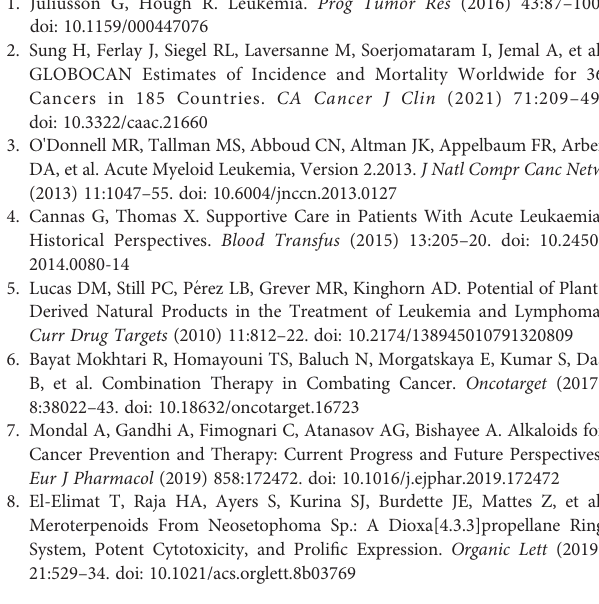
Supplementary Figure 1 | Spearman correlation between BUB1B and FOXM1 in TCGA cancers plotted using log2 TPM expression values. Correlation score (r) and p values (p) are plotted on top left. LAML, Acute Myeloid Leukemia; ACC, Adrenocortical carcinoma; BLCA, Bladder Urothelial Carcinoma; LGG, Brain Lower Grade Glioma; BRCA, Breast invasive carcinoma; CESC, Cervical squamous cell carcinoma and endocervicaladenocarcinoma; CHOL, Cholangiocarcinoma; LCML, Chronic Myelogenous Leukemia; COAD, Colon adenocarcinoma; ESCA, Esophageal carcinoma; GBM, Glioblastoma multiforme; HNSC, Head and Neck squamous cell carcinoma; KICH, Kidney Chromophobe; KIRC, Kidney renal clear cell carcinoma; KIRP, Kidney renal papillary cell carcinoma; LIHC, Liver hepatocellular carcinoma; LUAD, Lung adenocarcinoma; LUSC, Lung squamous cell carcinoma; DLBC, Lymphoid Neoplasm Diffuse Large B-cell Lymphoma; MESO, Mesothelioma; MISC, Miscellaneous; OV, Ovarian serous cystadenocarcinoma; PAAD, Pancreatic adenocarcinoma; PCPG, Pheochromocytoma and Paraganglioma; PRAD, Prostate adenocarcinoma; READ, Rectum adenocarcinoma; SARC, Sarcoma; SKCM, Skin Cutaneous Melanoma; STAD, Stomach adenocarcinoma; TGCT, Testicular Germ Cell Tumors; THYM, Thymoma; THCA, Thyroid carcinoma; UCS, Uterine Carcinosarcoma; UCEC, Uterine Corpus Endometrial Carcinoma; UVM, Uveal Melanoma. Supplementary Figure 2 | Overall survival BUB1B for the solid tumors from TCGA. Higher expression of BUB1B is associated with poor overall survival in six different cancers. Supplementary Figure 3 | NSP-B synergistically enhanced the antiproliferative responseofthiostreptoninleukemiccells.K562 (A) andU937 (B) cellsweretreated withvarious combinations ofNSP-B and thiostrepton for 48 hours and graphs were generated.K562 and U937 cells were treated with different combinations of NSP-B and thiostrepton for 48 hours and cell viability assay were performed as mentioned in the method section. Different types of graphs were prepared using Calcusyn software as described by Chou and